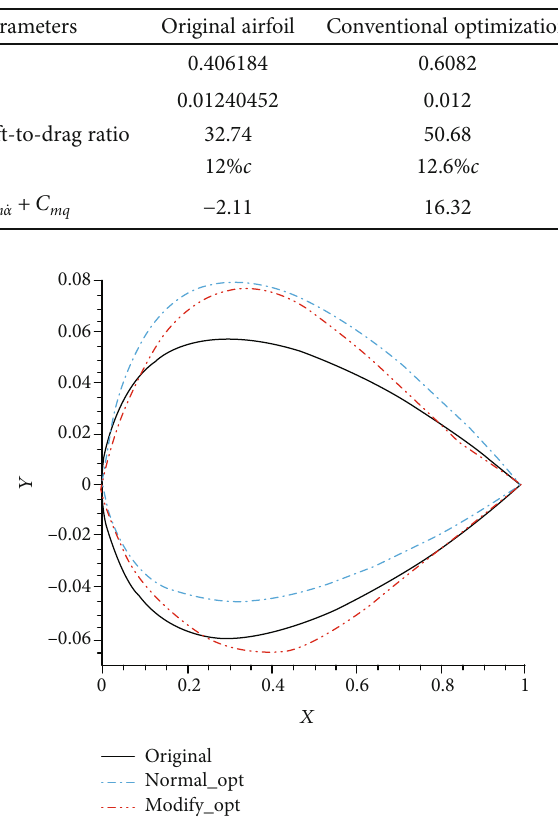
Table 2: Aerodynamic parameters after conventional optimization.